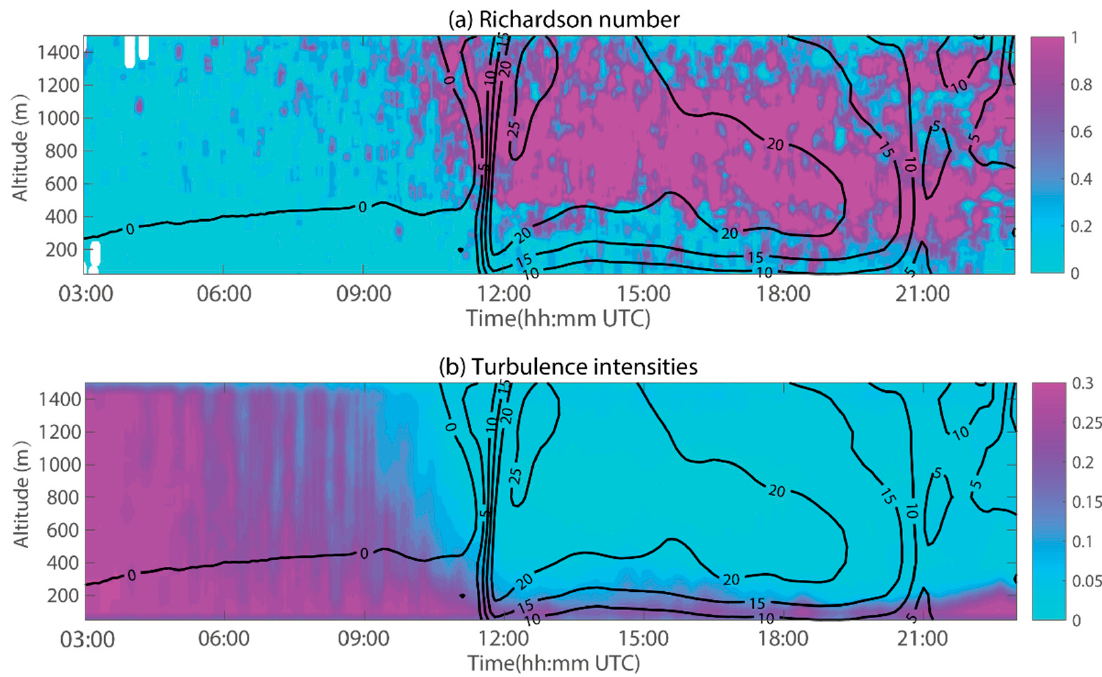
Figure 16. Turbulence intensities ( a ) and Richardson number ( b ) for 20 h at Daxing, Beijing, 2 May 2021. The black isopleth is the time–height cross-section of 𝑍 (unit: dBZ), which is the same as the fill color in Figure 6.